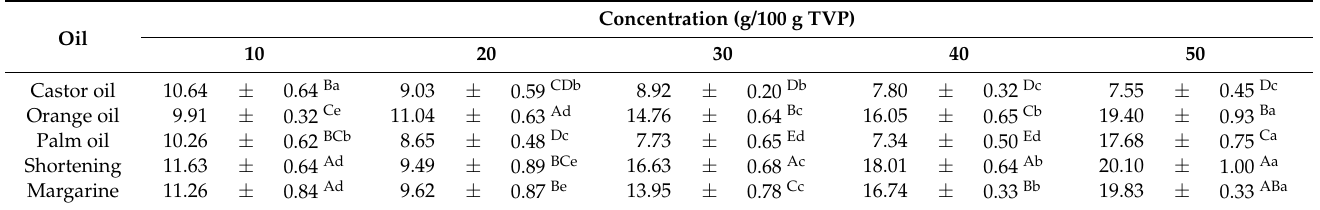
Table 2. Cooking loss (%) of meat analog supplemented with different types or amounts of veg- etable